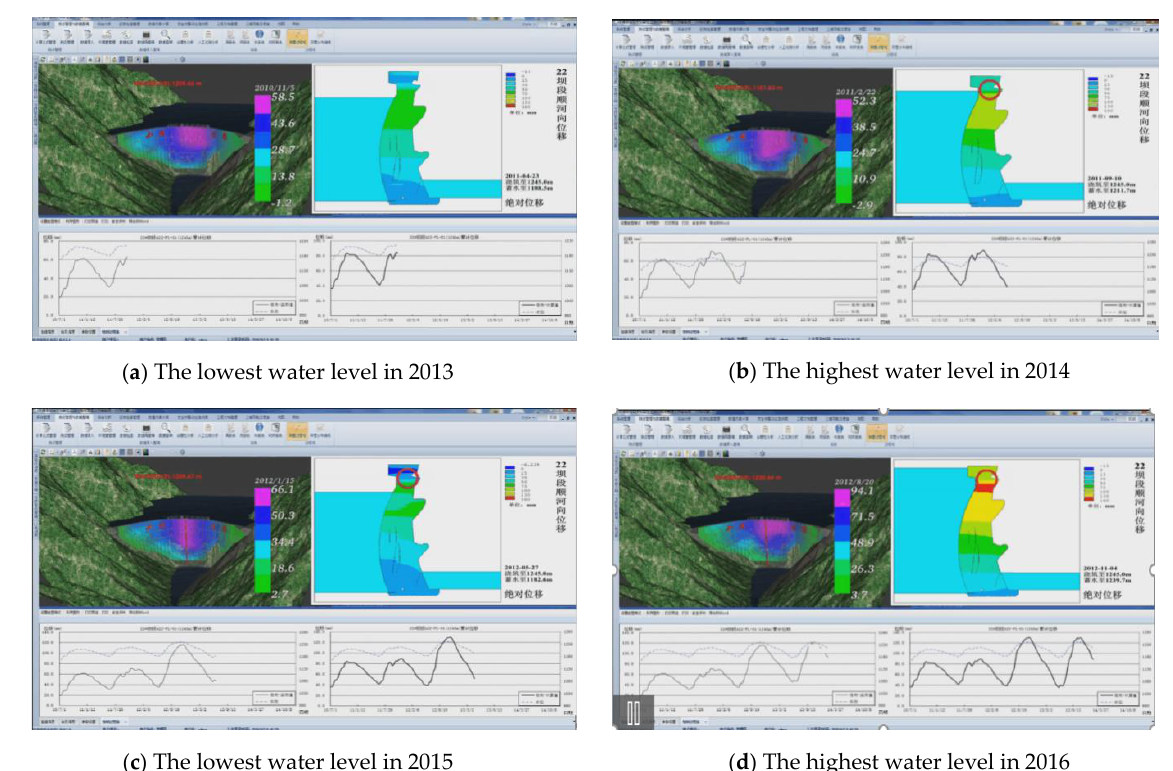
Figure 22. The application system for evaluation ( a ) the lowest water level in 2013; ( b ) the highest water level in 2014; ( c ) the lowest water level in 2015; ( d ) the highest water level in 2016.